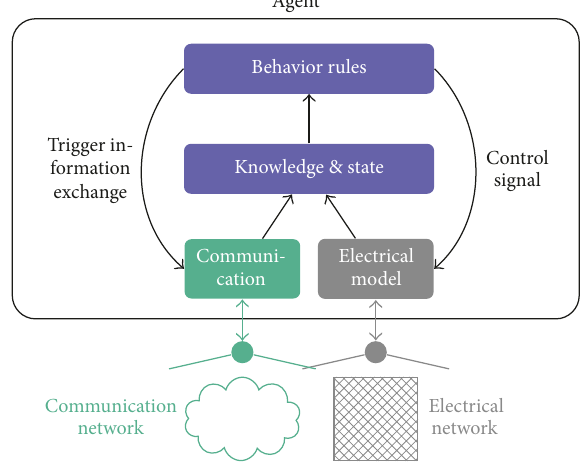
Figure 3: Model of a component agent and its connections to electrical and communication networks.